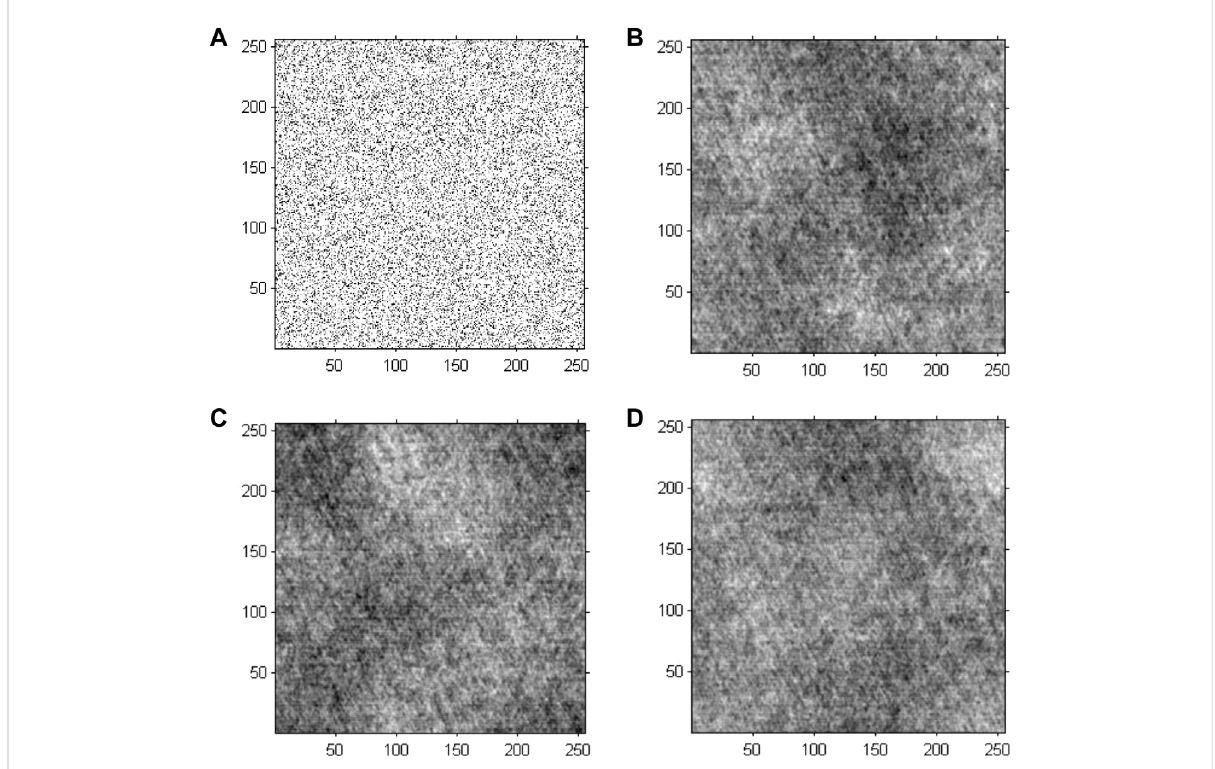
FIGURE 6 Phase reconstruction-based holographic image for Model 2 using the conventional GS algorithm. (A) Initial random phase, (B) 20 iterative reconstruction images of phase information, (C) 200 iterative reconstruction images of phase information, and (D) 2000 iterative reconstruction images of phase